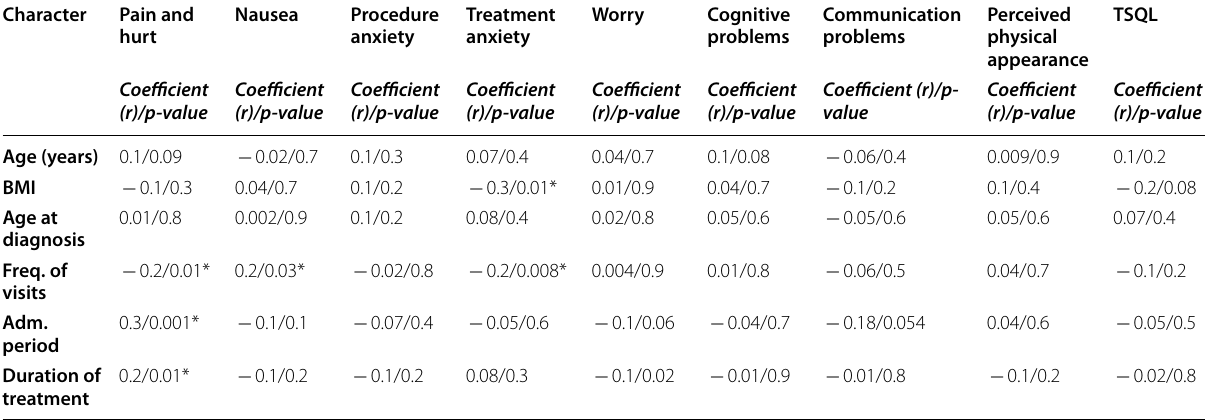
*Significant at the level